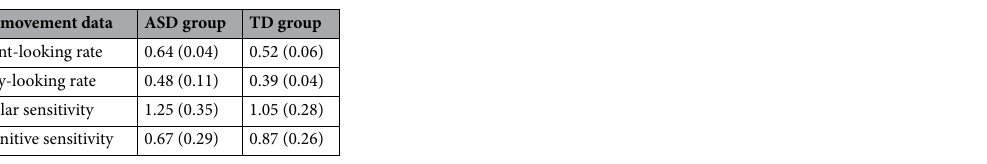
Table 3. Means with standard deviations in parentheses of eye movement measures for the two groups.